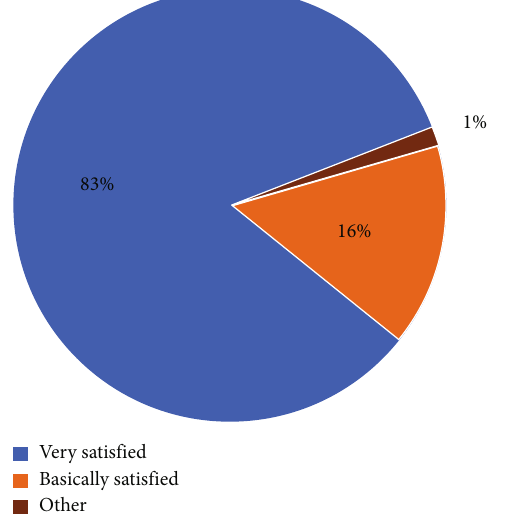
Figure 9: The result of the Keramos customer satisfaction questionnaire survey of ceramic furniture wardrobe combination after image di ff erence